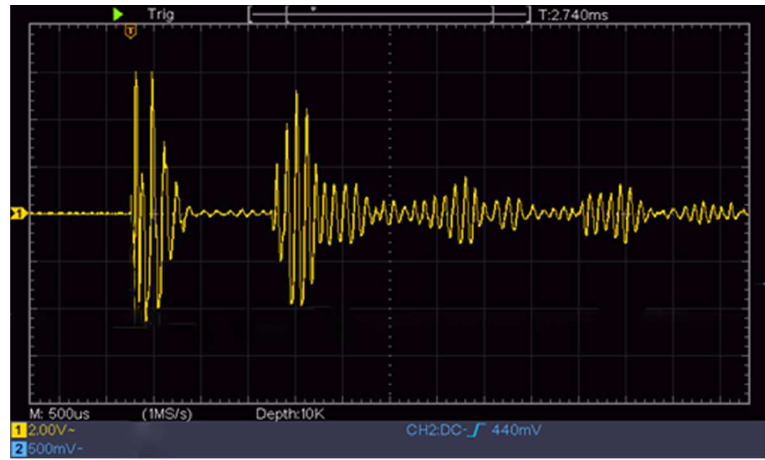
Figure 4. Ultrasonic echo time.